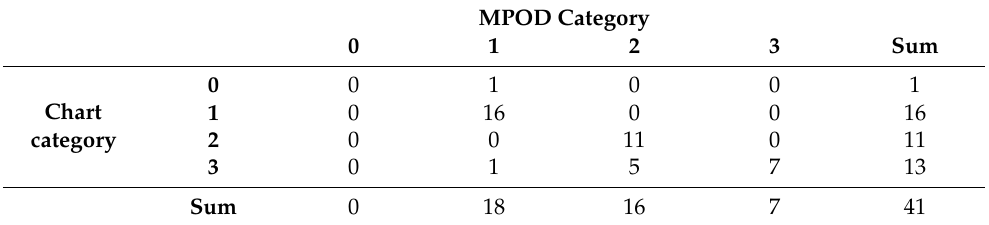
Table 4. Light box results. Cell values are numbers of eyes. Rows are chart categories, and columns are MPOD